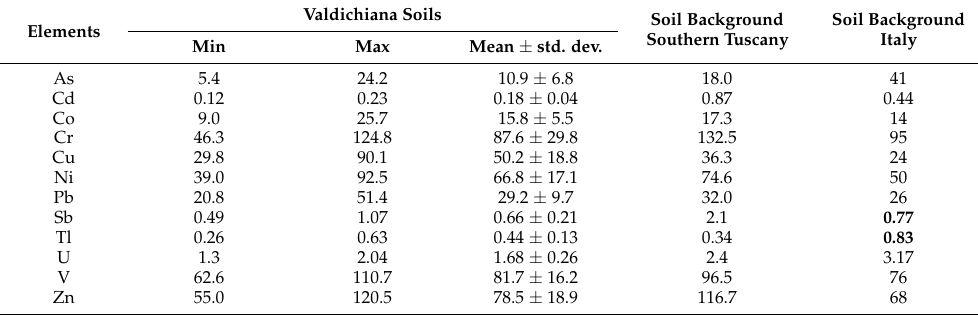
Table 5. Concentrations (mg/kg dw) of PTEs in AdV cultivation soils in the Valdichiana area, along with their background levels in soils of Southern Tuscany [22,23] and Italy [24]. Values in bold were calculated from the concentrations of PTEs in 51 surface soil samples collected in Italy [45]. Valdichiana Elements